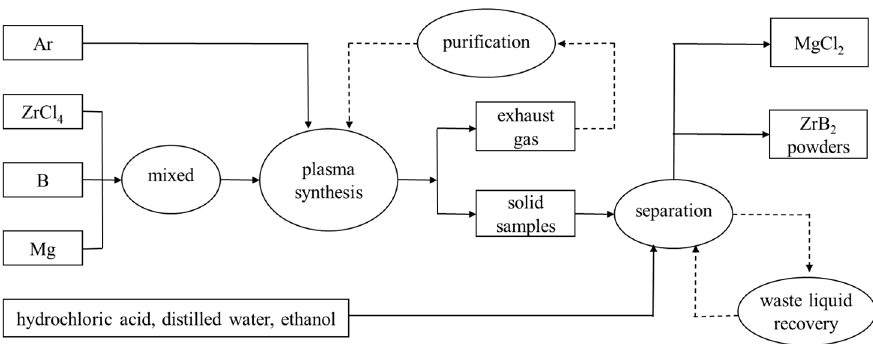
Scheme 5. Process flow chart for plasma synthesis of ultrafine ZrB 2 powders [96].